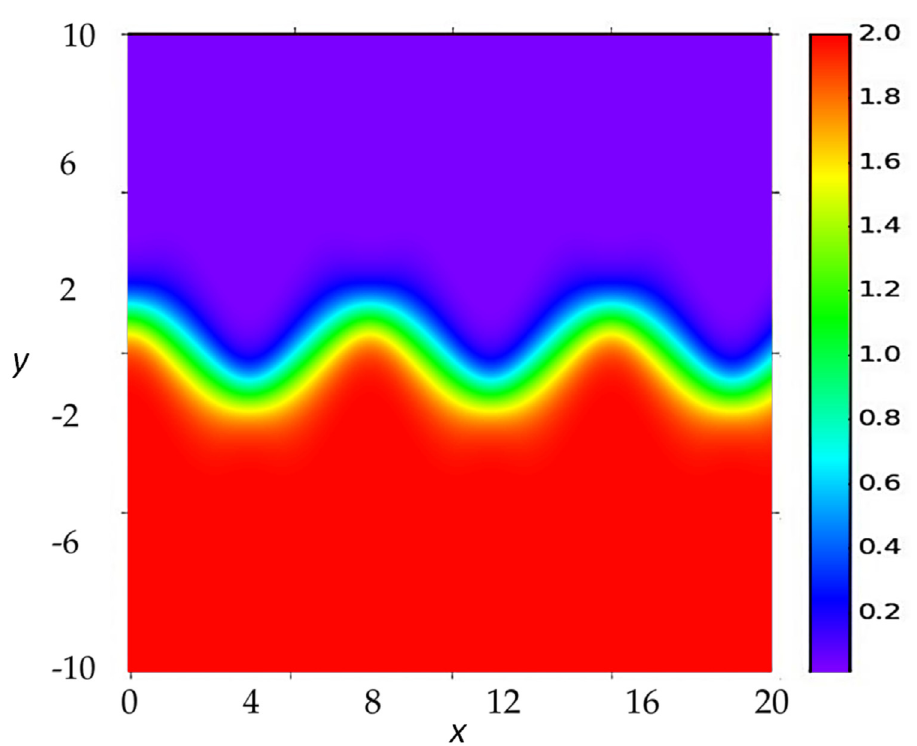
Fig 1. The streamfunction for the velocity field of the meandering flow. It describes a jet flowing from left to right, more intense in the central meandering core. The streamfunction is plotted here for ν = 0, and it is the same as for any other value of ν if t = 0 or a multiple of the flow period. Other parameters are given in the